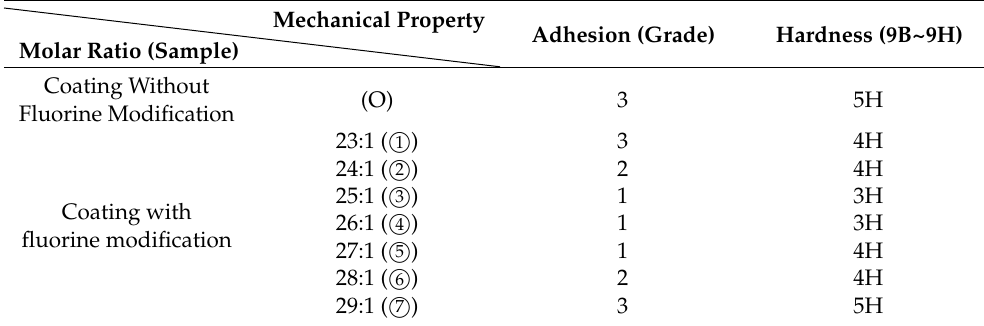
Table 2. Adhesion and hardness of coating with and without fluorine modification (samples with different molar ratios of epoxy group to DFHMA).